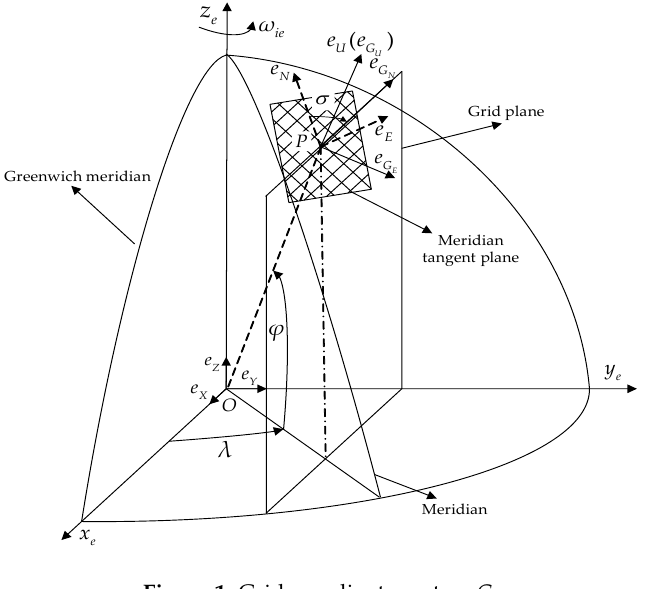
Figure 1. Grid coordinate system G .